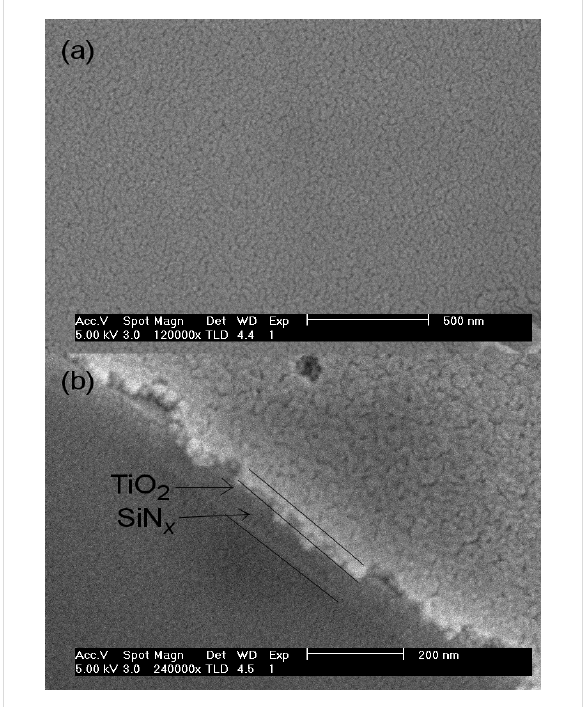
Figure 1: SEM images of the (a) top surface and (b) cross section of the sol–gel TiO 2 films grown on 75 nm thick SiN x /SLG after annealing at 450